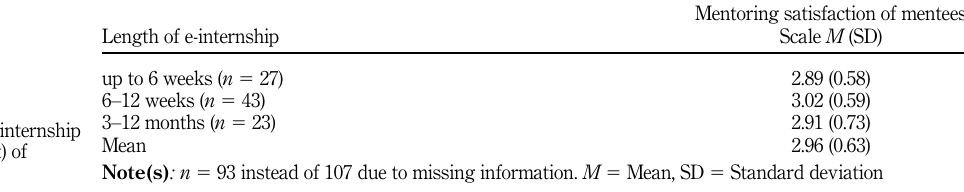
Table 1. Length of e-internship (most recent) of